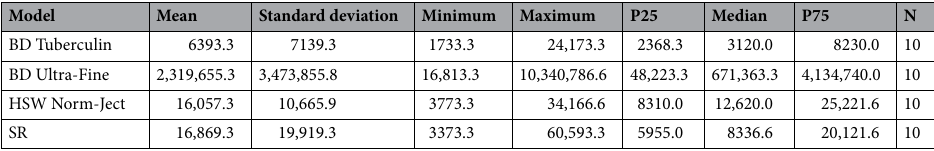
Table 1. Summary of particle numbers/mL by syringe model.